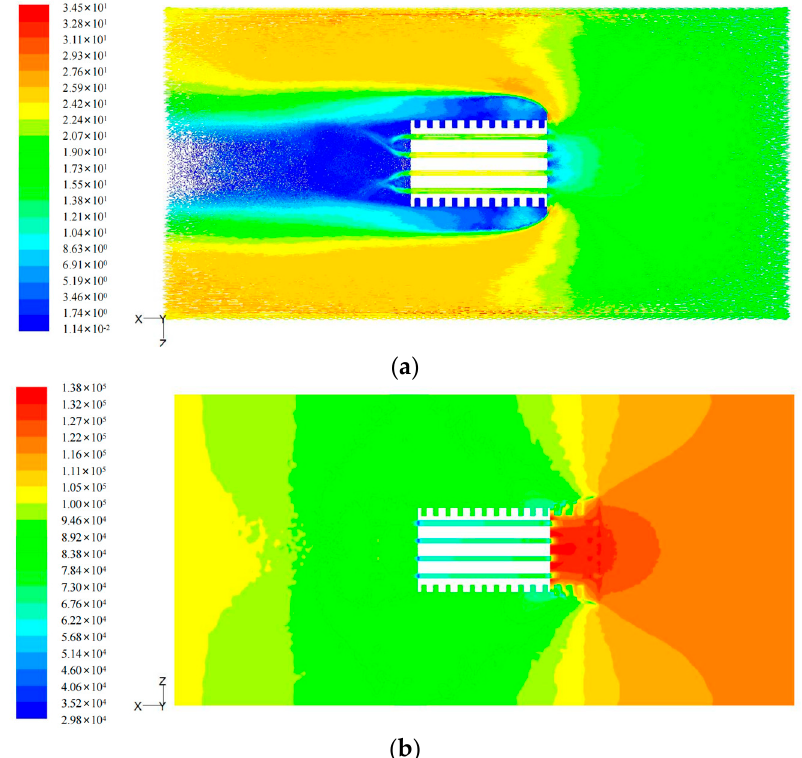
Figure 6. Water film condition (water film thickness = 6 mm, v = 75 km/h): ( a ) flow velocity distribution and ( b ) hydrodynamic pressure distribution.